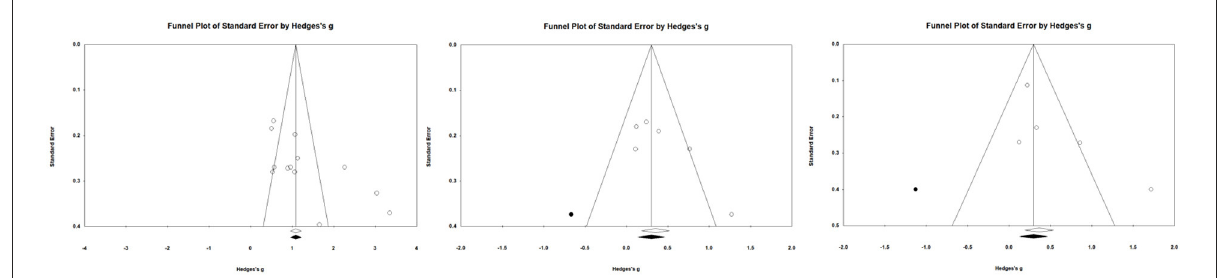
FIGUREA1 Funnel plot of standard error by Hedge’s g